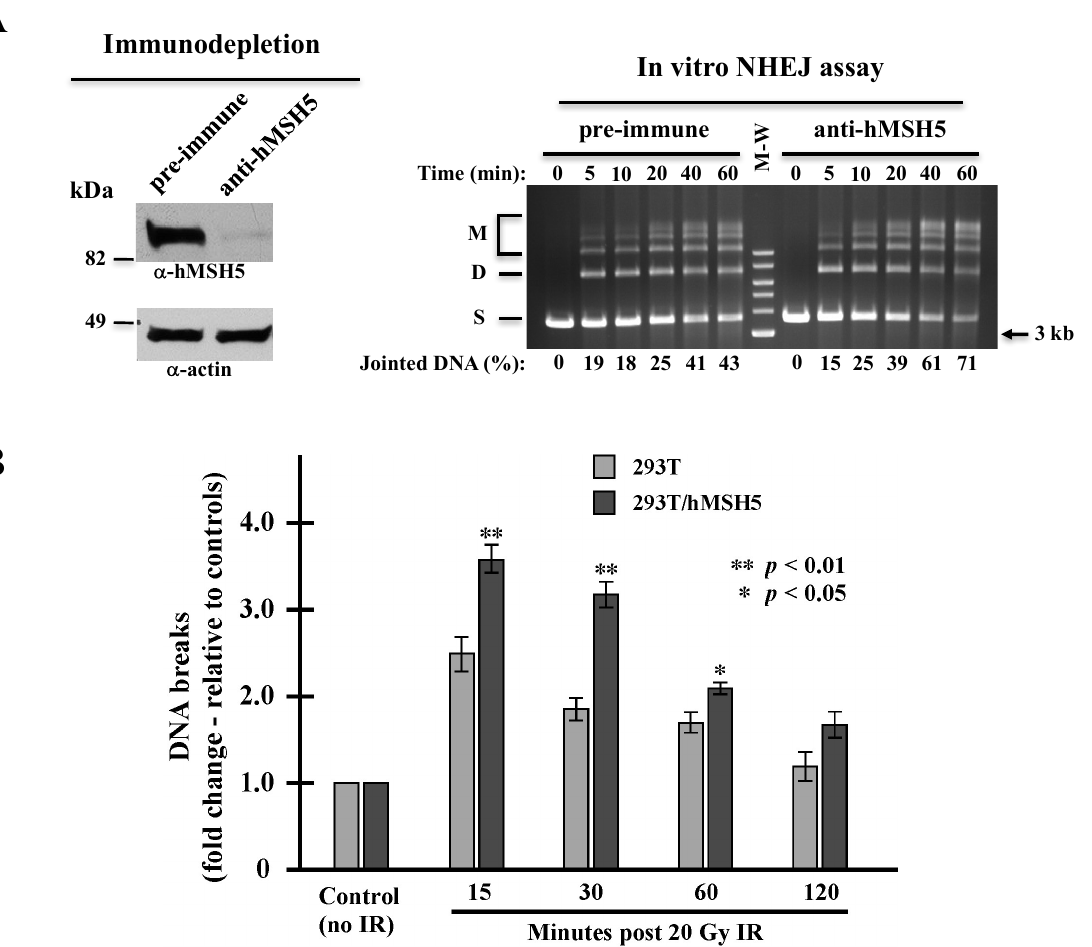
Figure 3. Effects of hMSH5 on NHEJ. ( A ) In vitro NHEJ analysis of NHEJ activities in hMSH5- depleted extracts in comparison to extracts depleted by pre-immune serum. Immunoblotting analysis of hMSH5 depletion from 293T/hMSH5 extracts is shown on the left. End-joining reactions were carried out by incubating cell extracts with Sal I-digested plasmid DNA as described previously [49]. ‘S’ represents linear DNA substrate, ‘D’ for joint dimer, and ‘M’ signifies higher order joint products. Relative NHEJ activities (%) were percentages of total substrate loss determined by quantification at each time point (right panel). ( B ) Assessing the effect of hMSH5 on IR-induced DSB repair by PFGE. The detection of DNA breaks in 293T and 293T/hMSH5 cells by PFGE analysis was performed at indicated times following IR exposure. Fold change in DNA fragmentation was determined by using an untreated sample as a reference. Error bars represent standard deviations from the means of three replicates. Statistical significance was determined by Student’s two-tailed t -test.